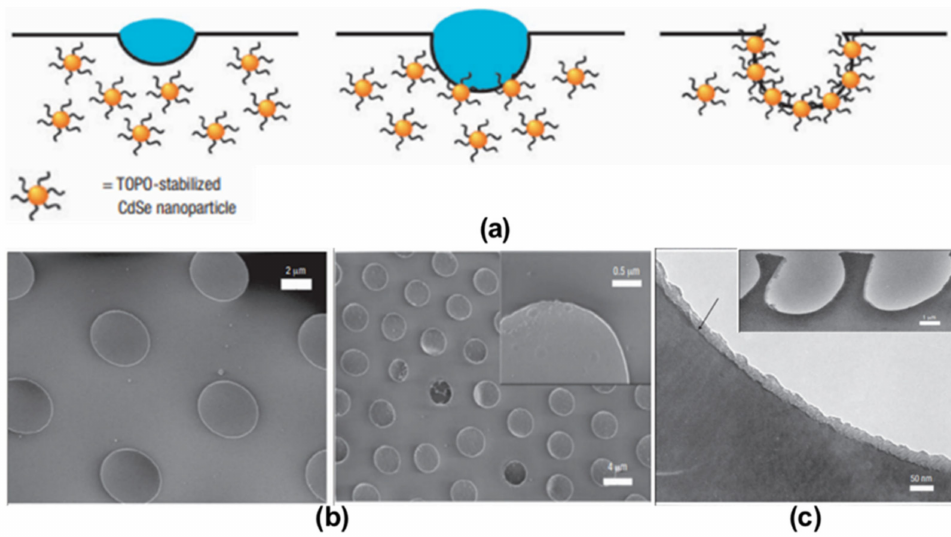
Figure 4. ( a ) Cross-sectional diagram of nanoparticle assembly at a water droplet–solution interface during the breath-figure formation. ( b ) SEM images of the surface of an NP-decorated BF film. ( c ) TEM images of cross-sections through porous PS film. Reprinted with permission from ref. [86]. Copyright 2004 Nature Materials.